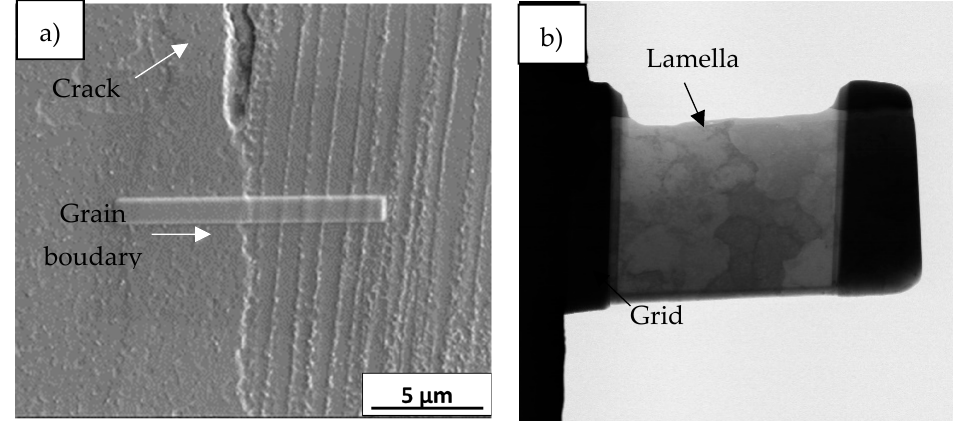
Figure 2. ( a ) Lamella extraction at a grain boundary and ( b ) lamella.